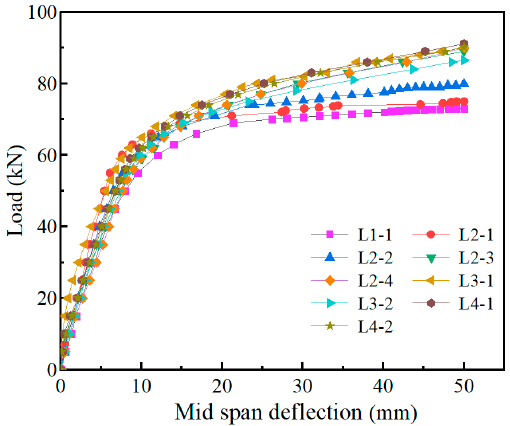
Figure 10. The load–midspan deflection curve. Table 5. Mechanical properties test data of specimens. Specimen